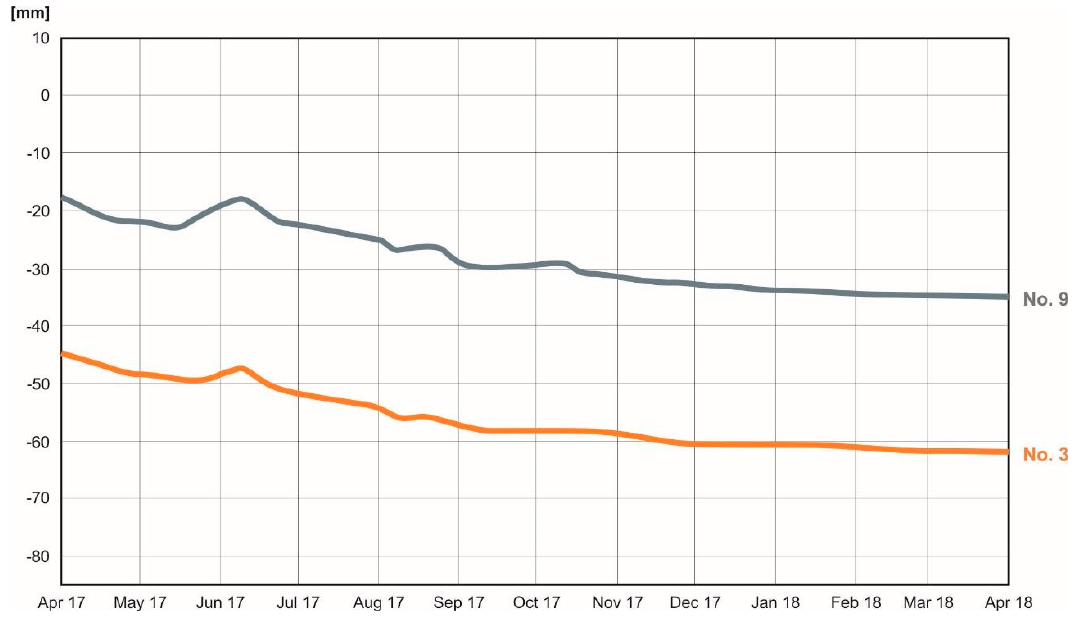
Figure 14. Subsidence of the “Prague bridge abutment” of the Prackovice overpass at km 57,450, measured in situ by total station in the period between April 2017 and April 2018. The most significant subsidence was 18 and 17 mm at points No. 3 and No. 9 of the geotechnical profile P4. The values derived from both scenarios correspond well with these in situ measurements. In